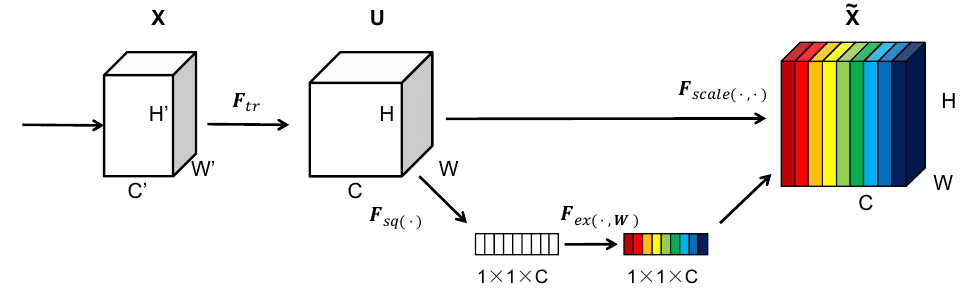
Figure 6. A Squeeze and Excitation block